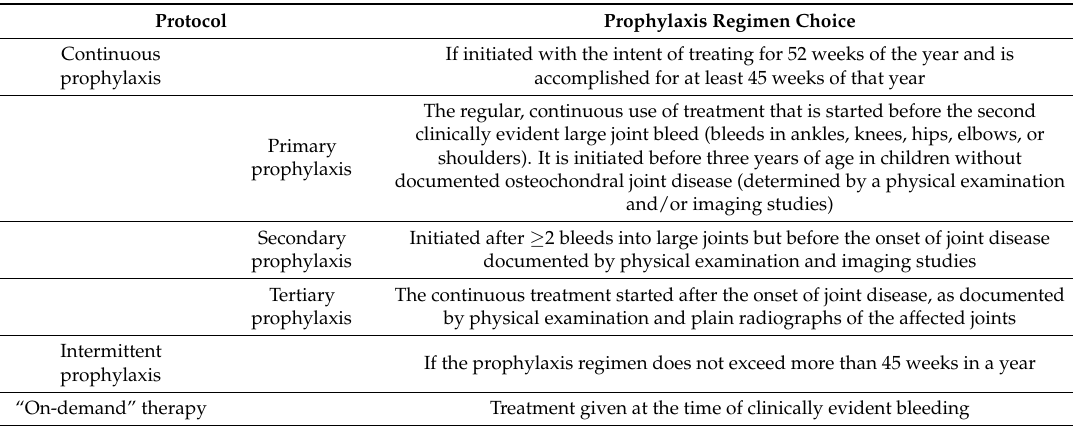
Table 1. Definition of factor replacement protocol and prophylaxis regimen choice